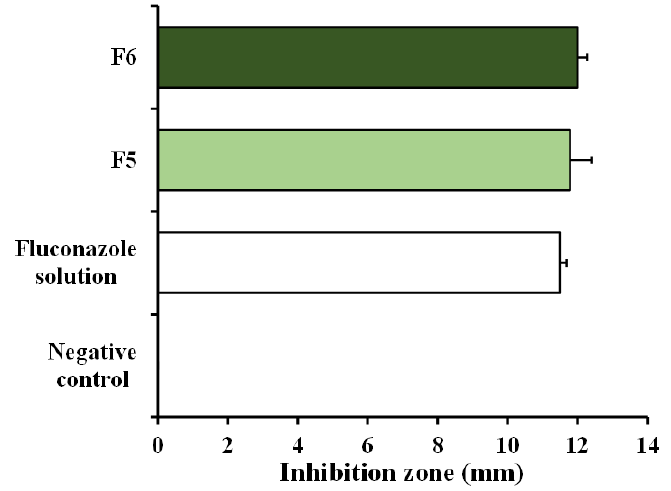
Figure 6. Anticandidal activity expressed as the inhibition zone of the fluconazole mixtures prepared from F5 and F6 tablets. Each value is the mean ± S.D., n = 3.